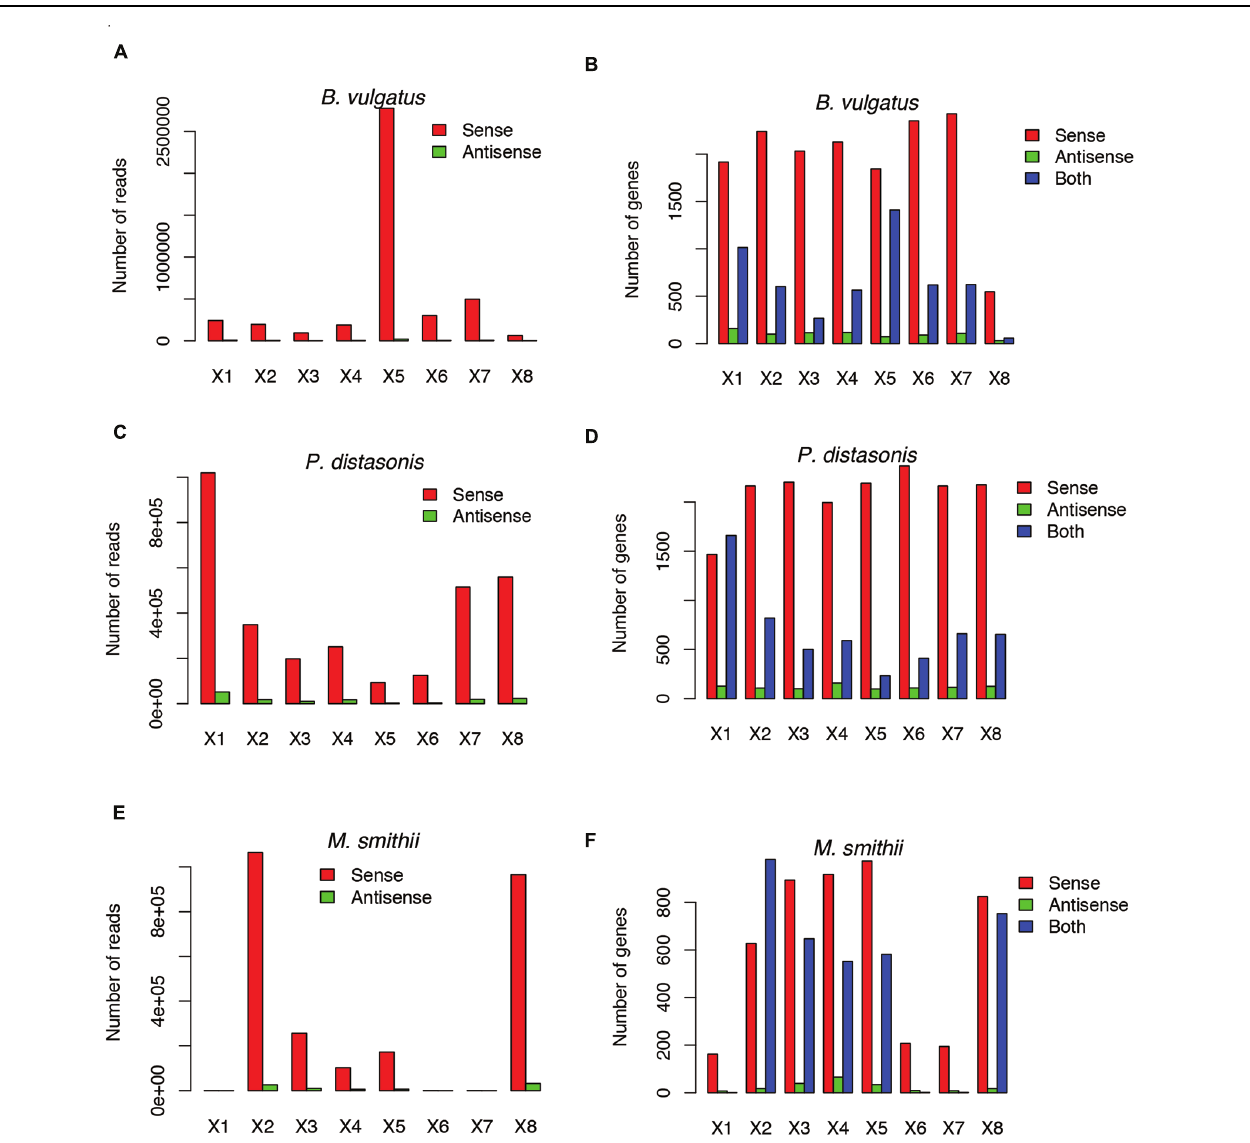
FIGURE 4 | Example species with antisense transcription in different individuals. Three species are shown: Bacteroides vulgatus ATCC 8482 (A,B) , Parabacteroides distasonis ATCC 8503 (C,D) and Methanobrevibacter smithii ATCC 35061 (E,F) . (A,C,E) Shows the numbers of sense and antisense reads in these three species, and (B,D,F) show the number of genes with sense transcription only (Sense), antisense transcription only (Antisense), and both (Both). X1–X8 indicate the eight individuals.